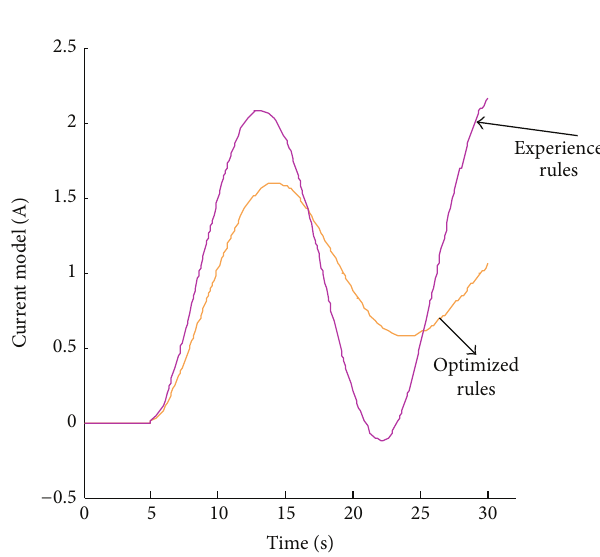
Figure 6: Membership function graphics.